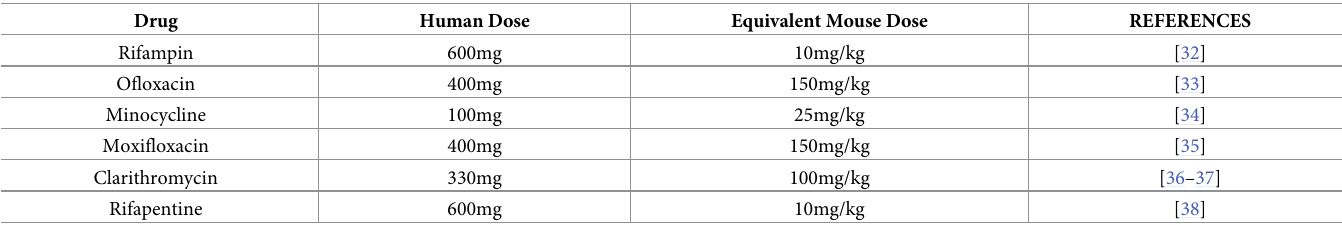
Table 1. Drugs used in